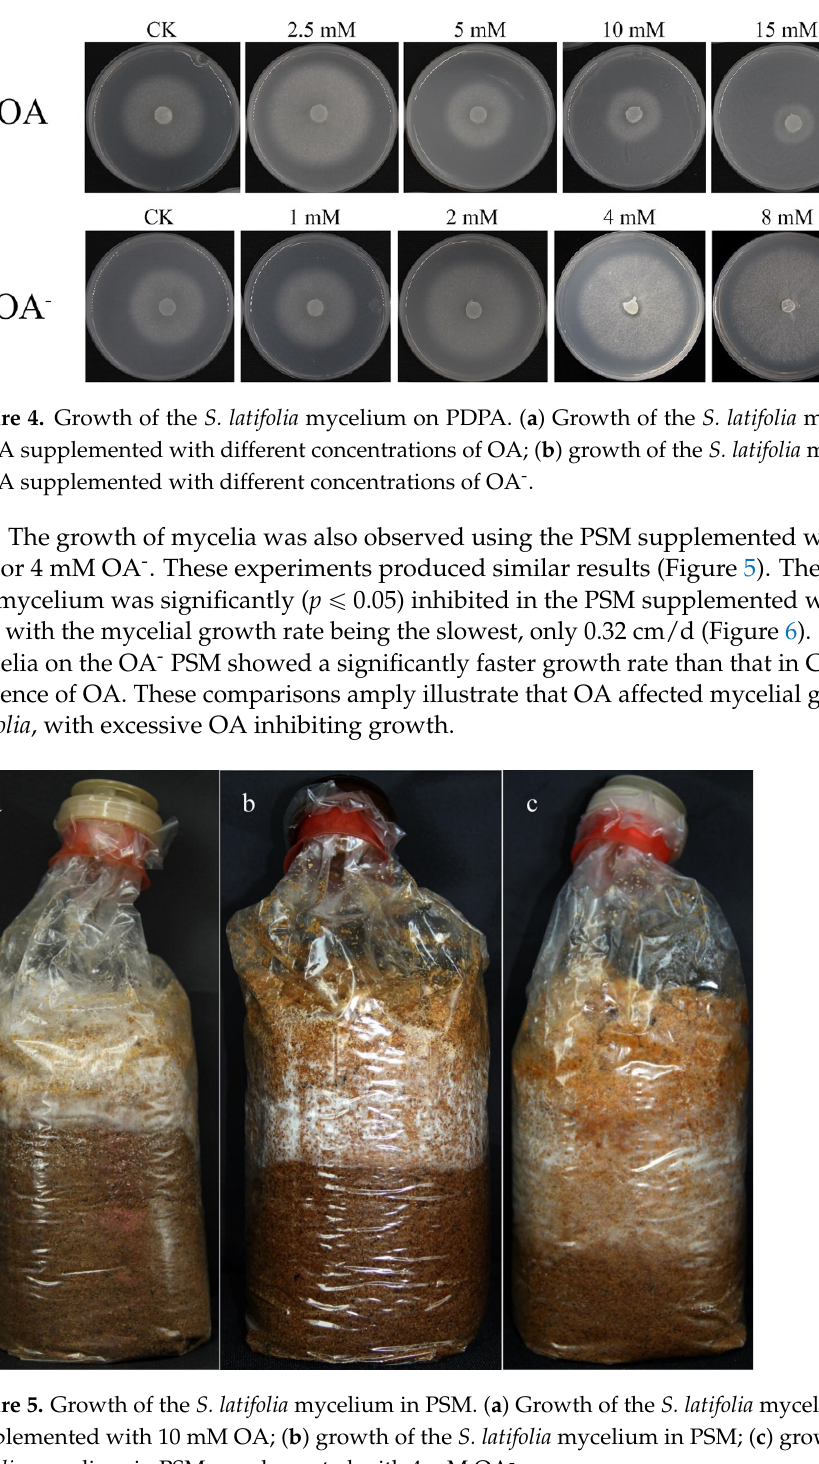
Figure 6. Growth rate of the S. latifolia mycelium in PSM supplemented with OA and OA - . CK: PSM, OA: PSM supplemented with 10 mM OA, OA - : PSM supplemented with 4 mM OA - . Data were an- alyzed with Duncan’s ANOVA test. Error bars represent the standard deviation of three replicates. Different letters indicate significant differences between the lines ( p ≤ 0.05).